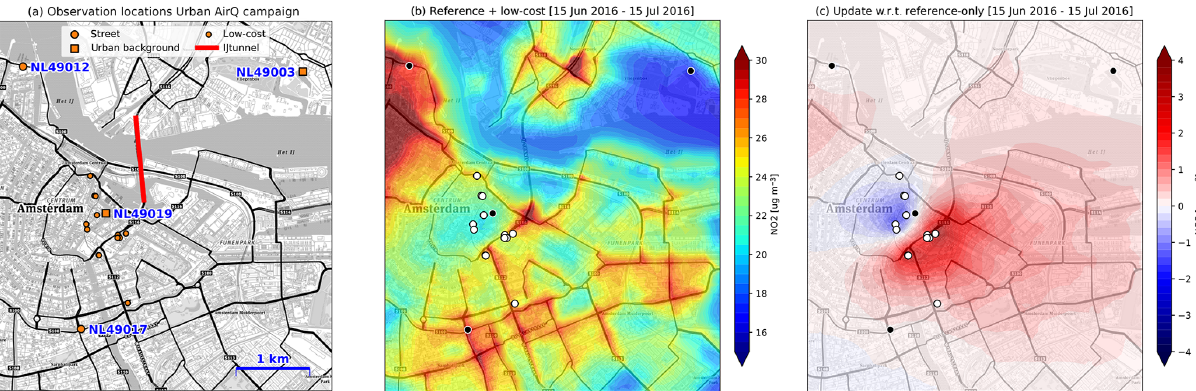
Figure 10. (a) Observation sites during the Urban AirQ campaign. (b) The 30d average of NO 2 concentrations in the centre of Amsterdam, after assimilation of both reference measurements (black dots) and low-cost measurements (white dots). (c) Changes in spatial pattern when low-cost measurements are included in the analysis. (Basemap source: © Mapbox © OpenStreetMap contributors 2019. Distributed under a Creative Commons BY-SA